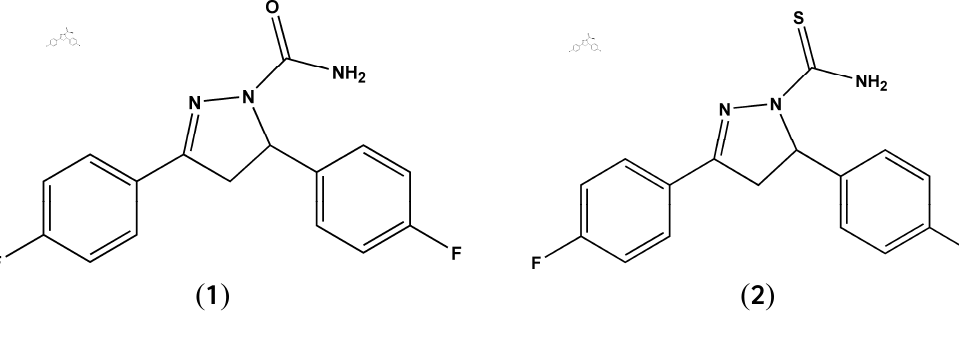
H F N 16 13 2 3